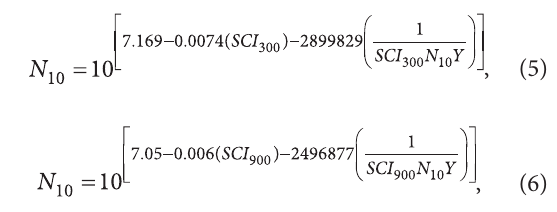
Table 2. Pavement structures Pavement ID